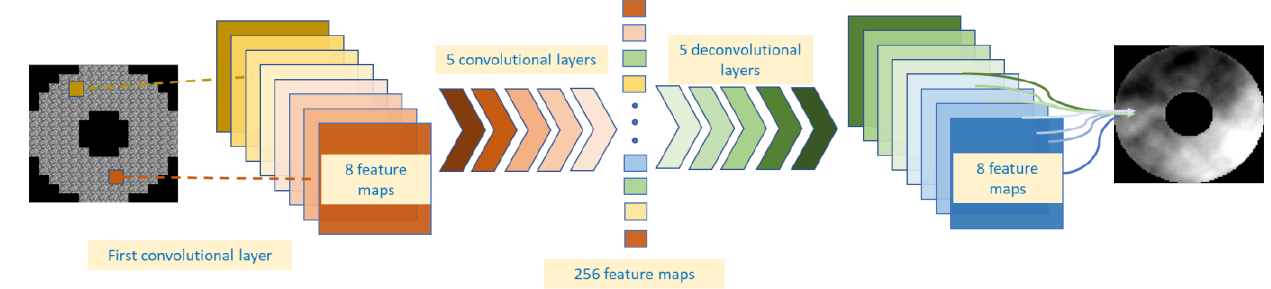
Figure 1. Schematic representation of the FCN used throughout this research. The comparison is made in both cases with the same FCN topology.